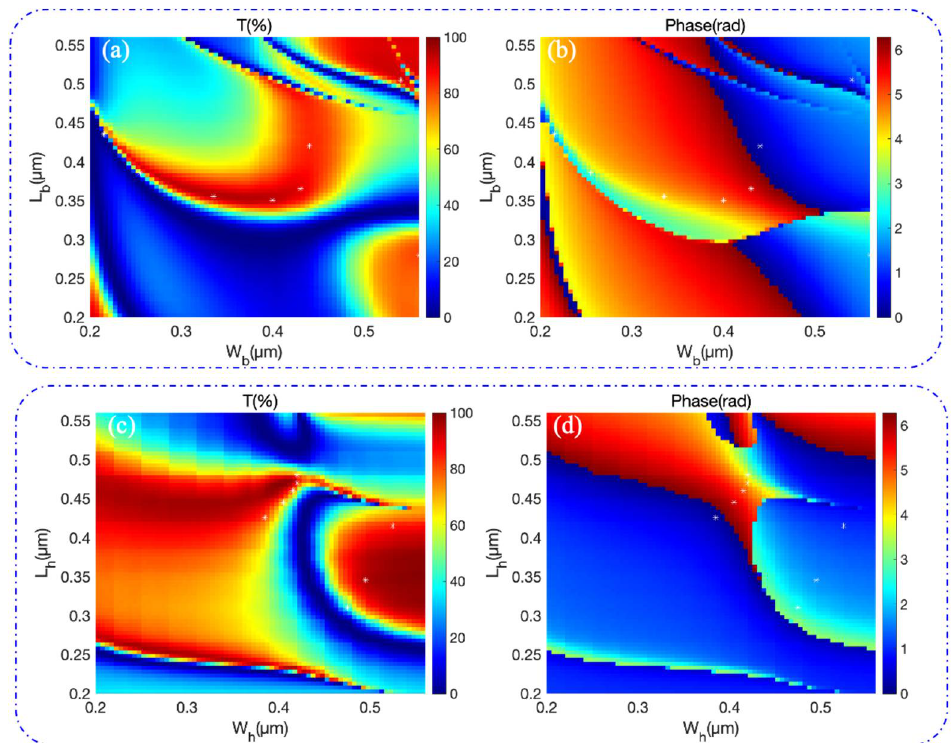
Figure 2. Optical properties of the unit-cells with nanobricks and nanoholes: ( a ) Transmittance and ( b ) Phase difference of the brick unit-cells as a function of L b and W b ; ( c ) Transmittance and ( d ) Phase difference of the hole unit-cells as a function of L h and W h .